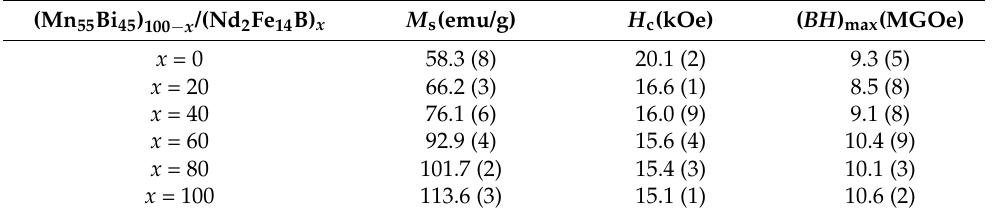
Table 3. The magnetic properties of the bulk (Mn 55 Bi 45 ) 100 − x /(Nd 2 Fe 14 B) x hybrid magnetic alloys at 350